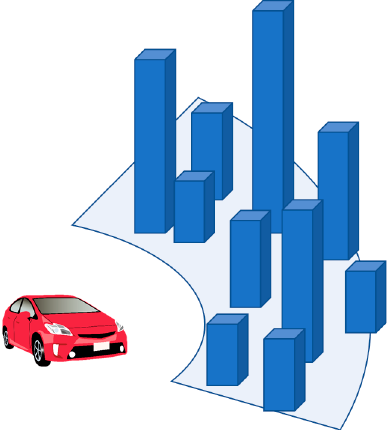
Figure 1. Illustration of the segmented annular region for modeling distribution of the shading objects around the photovoltaic (PV) panel.